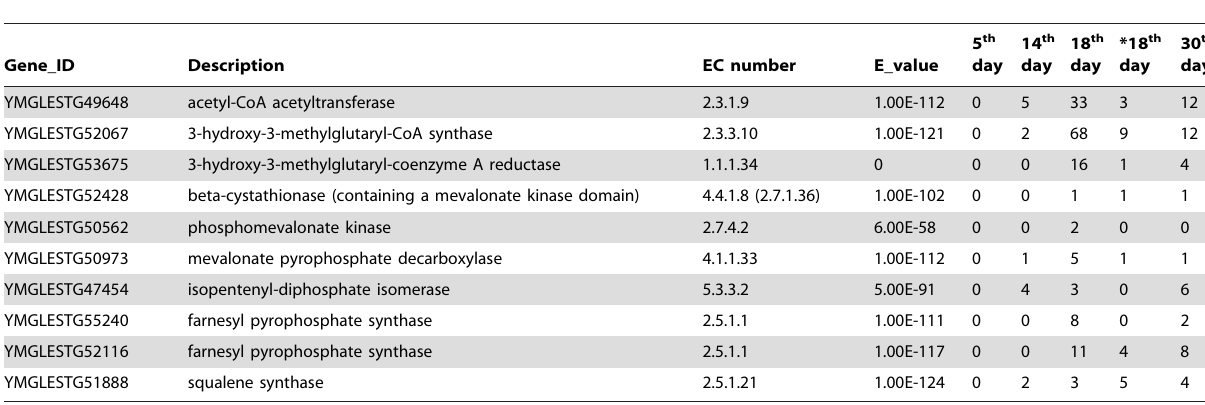
Table 3. G. lucidum genes and their ESTs involved in the biosynthesis of triterpenoids.